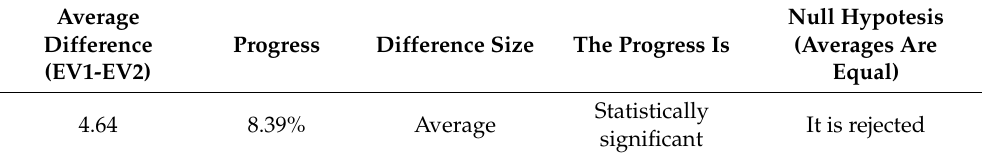
Table 8. Table of average differences of percentage weight distribution on the left